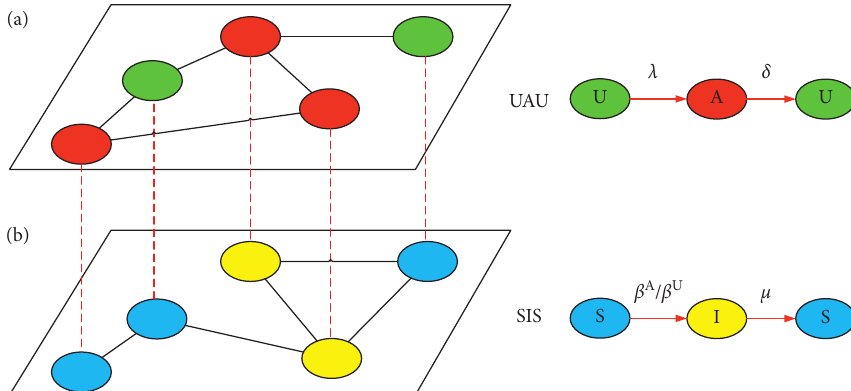
Figure 2: Schematic of the model. The dynamics of information spreading are described using the UAU model in the information network. The epidemic spreading process is described by the SIS model in the contagion network.